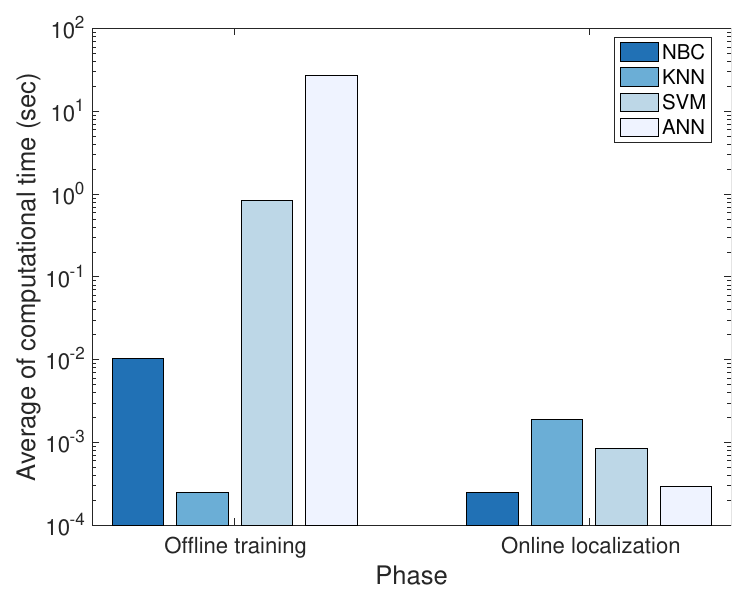
Figure 11. Average execution time of offline and online phase in machine learning